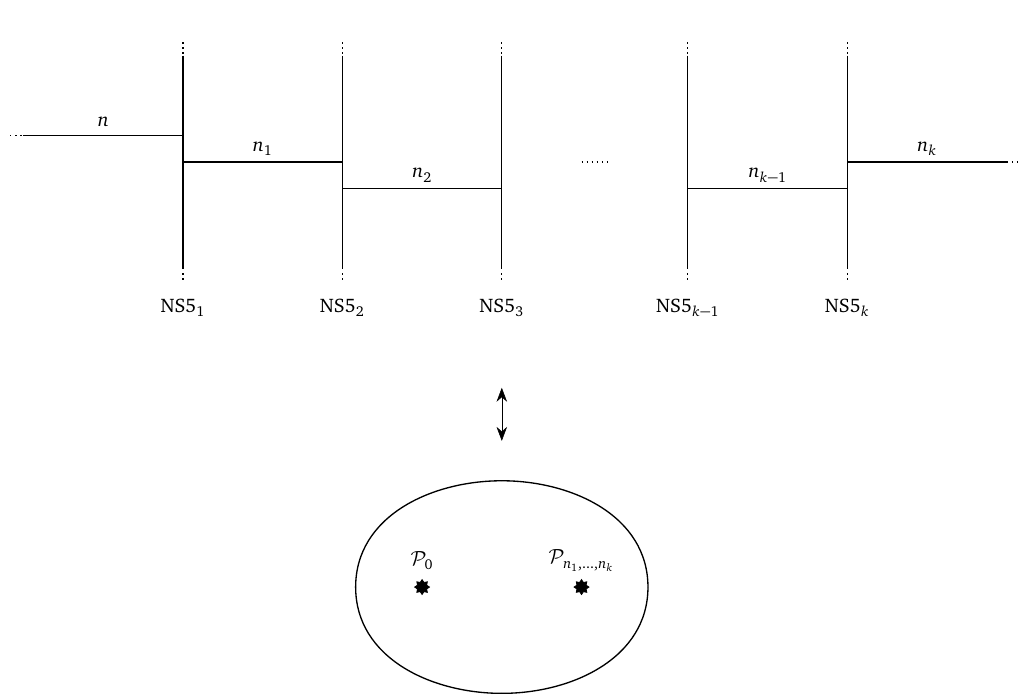
( 2,0 ) theory com- n − 1 , and the other of 0